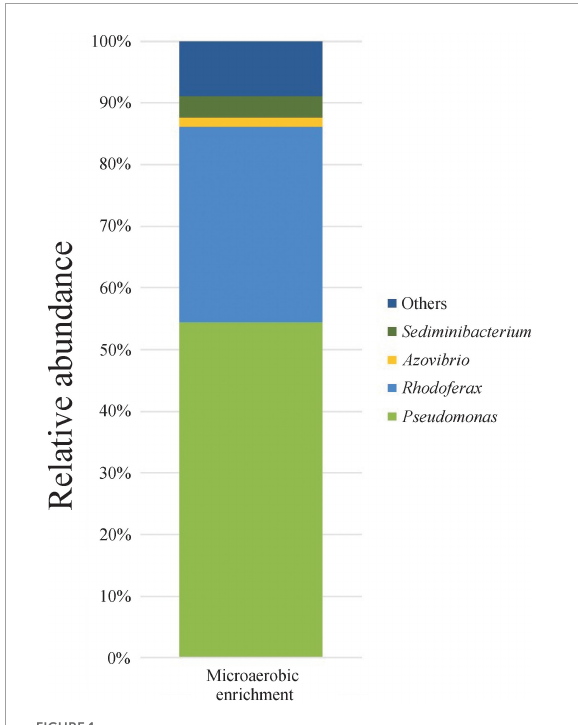
FIGURE1 Genus-level bacterial community structure of microaerobic xylene-degrading enrichment as revealed by Illumina paired-end 16S rRNA gene amplicon sequencing. Only taxa contributing more than 1% abundance were